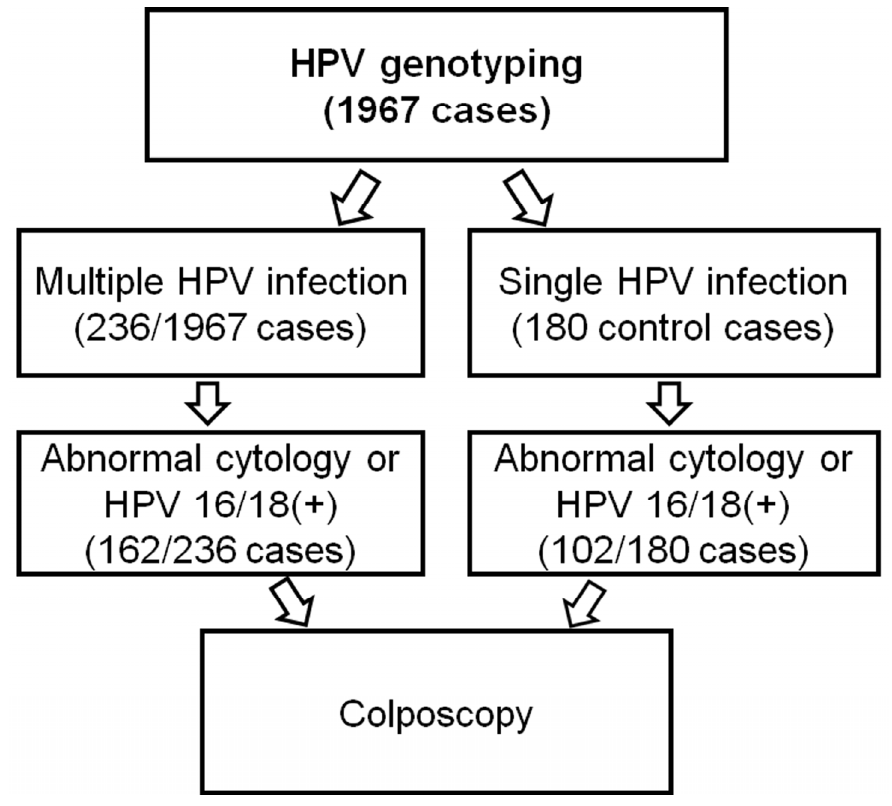
Figure 1. Selection of study cases.